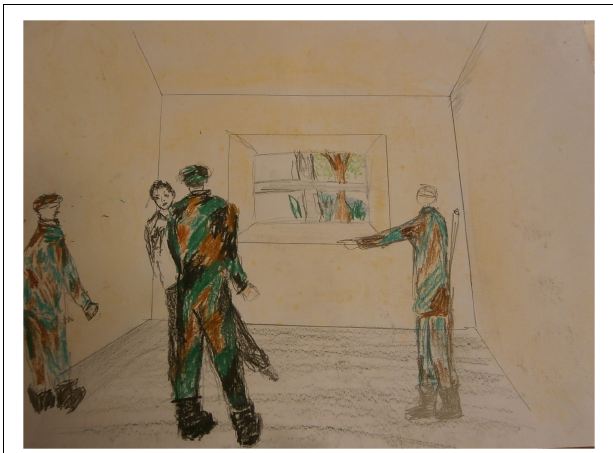
FIGURE 6 | Drawing of traumatic experiences around a military checkpoint.